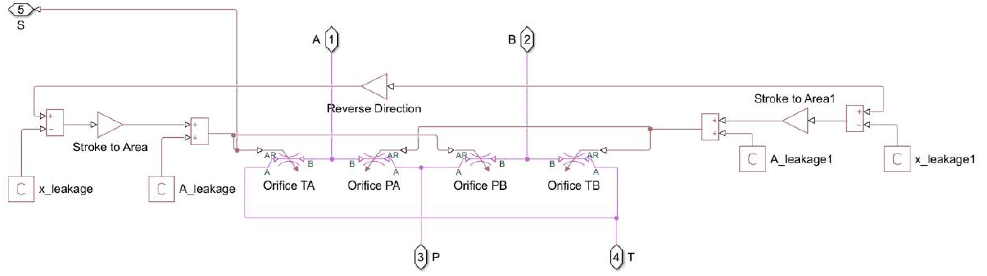
Figure 4. The SimScape model of the